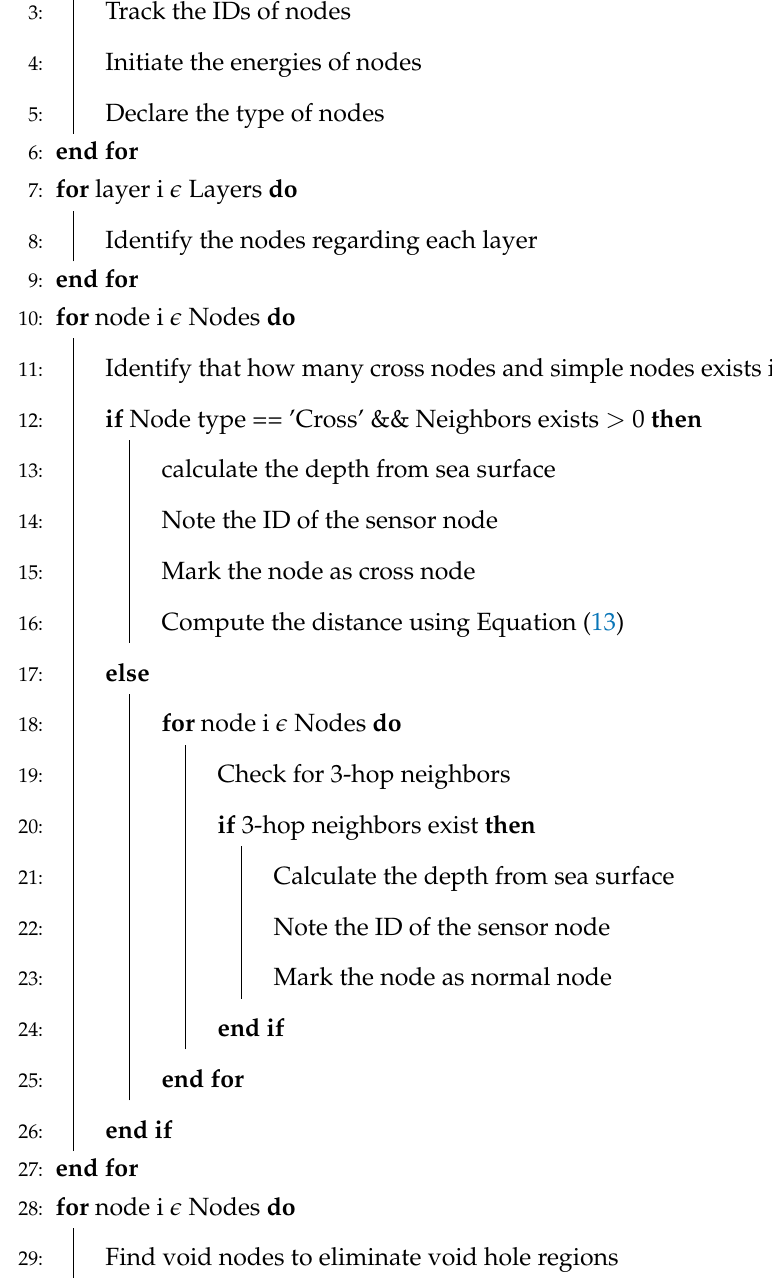
Algorithm 2 BFS-SPF-Three